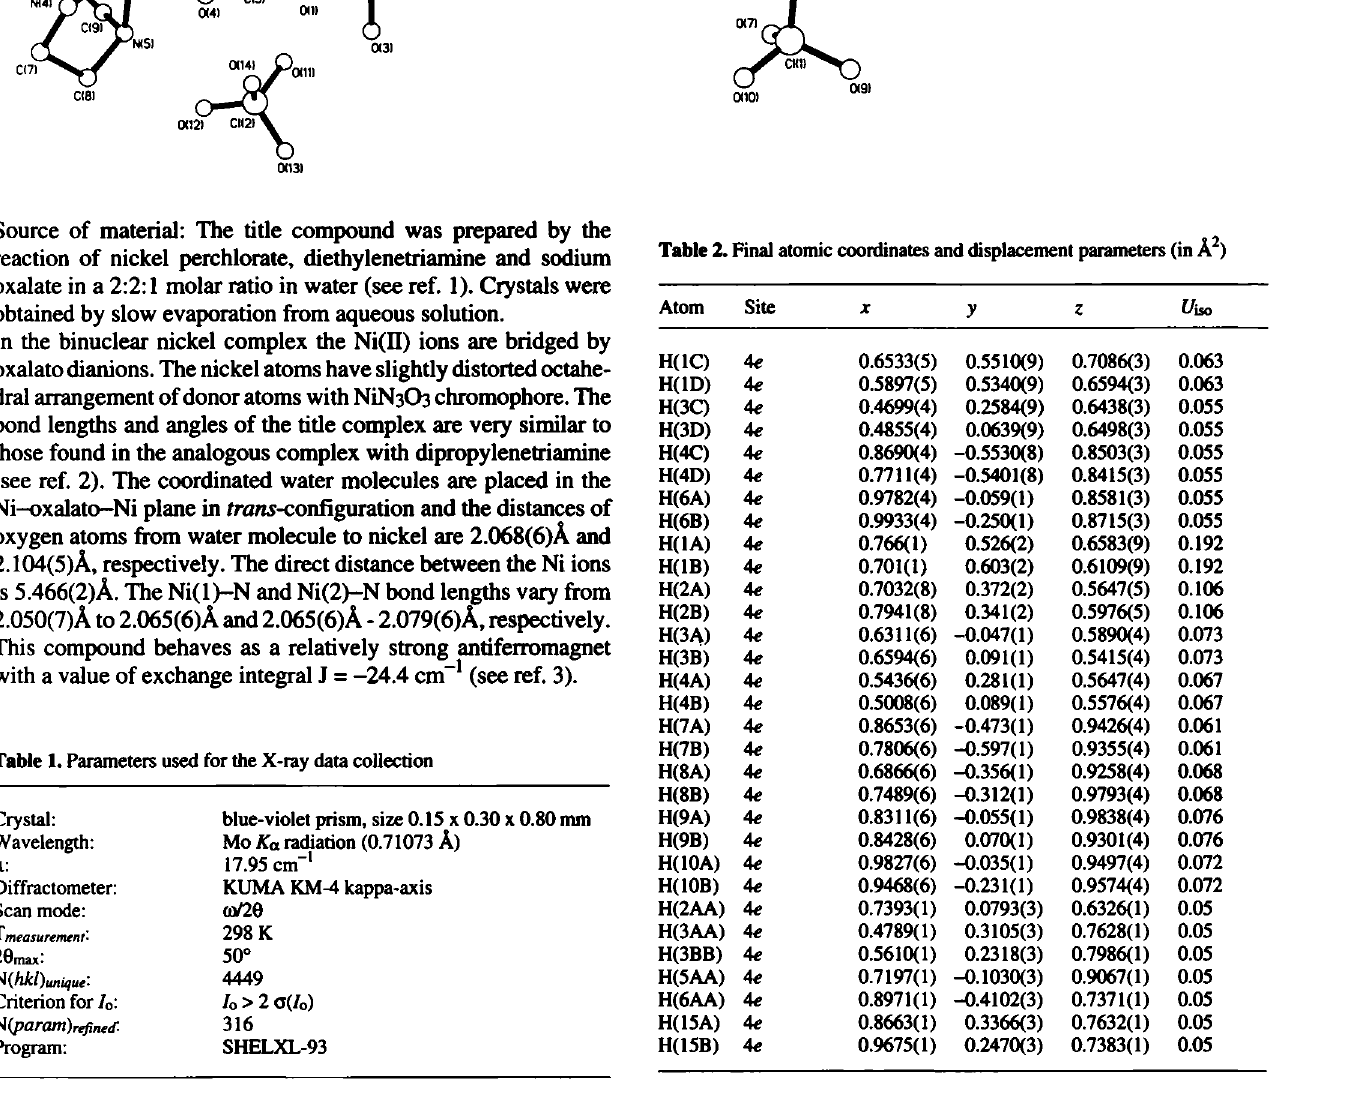
Table 1. Parameters used for the X-ray data collection